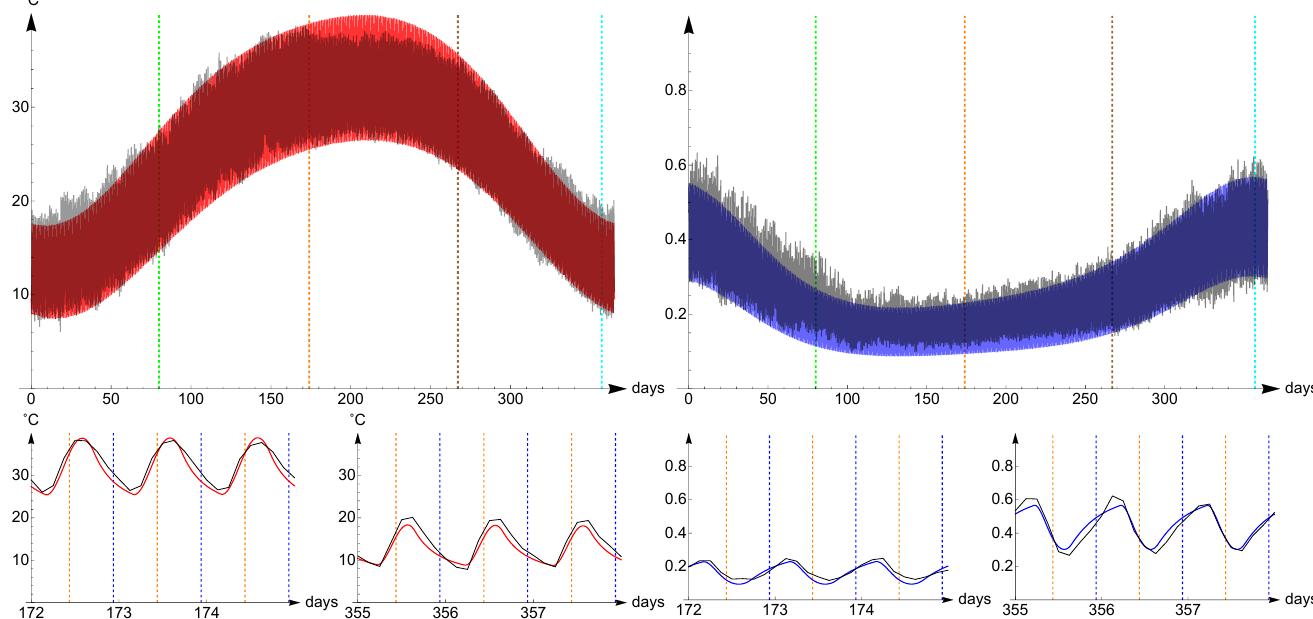
Figure 5. Mean and computed temperature ( left ) and relative humidity ( right ) in Kufra during the year ( top ) and on solstices and equinoxes ( bottom ). In black the average temperatures and humidities, in red simulated temperatures, in blue simulated humidity, the grid lines represent solstices, equinoxes, noons and midnights.